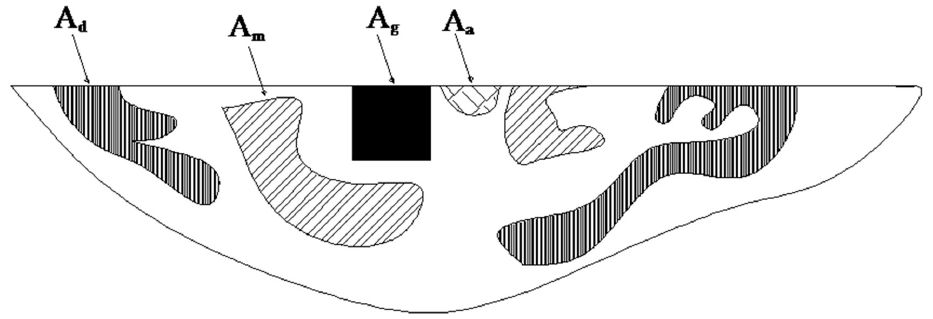
Figure 4. PZ with regions of accumulated (shown as A a ), mixed (A m ) and dispersed (A d ) reinforcement. A g is the initial grooved in which reinforcement was packed.